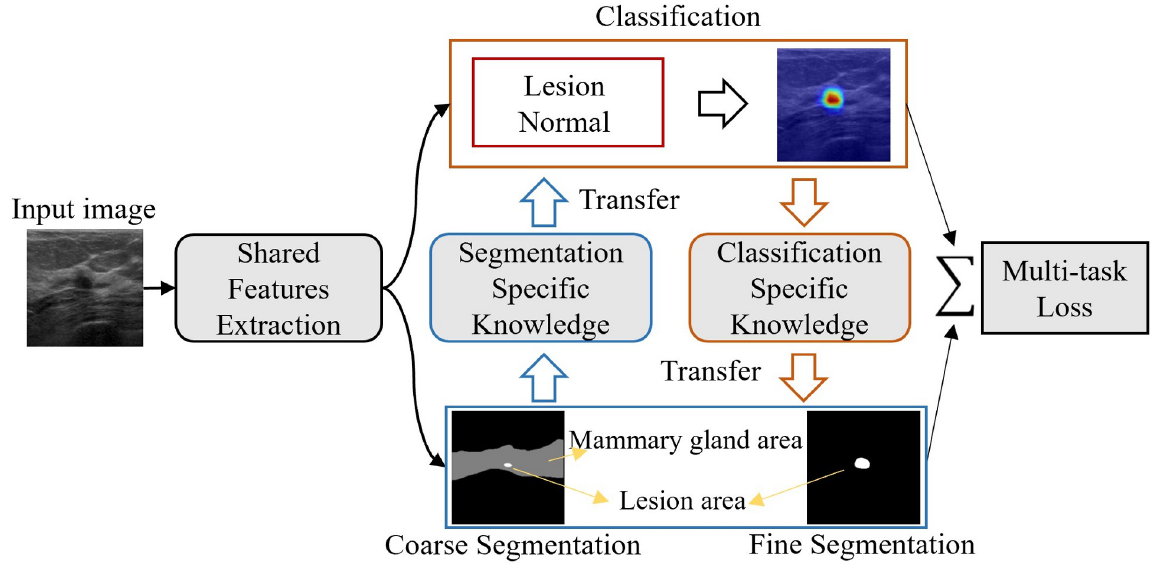
Fig 4. Illustration of the cross-task approach for achieving mutual improvement between tasks.